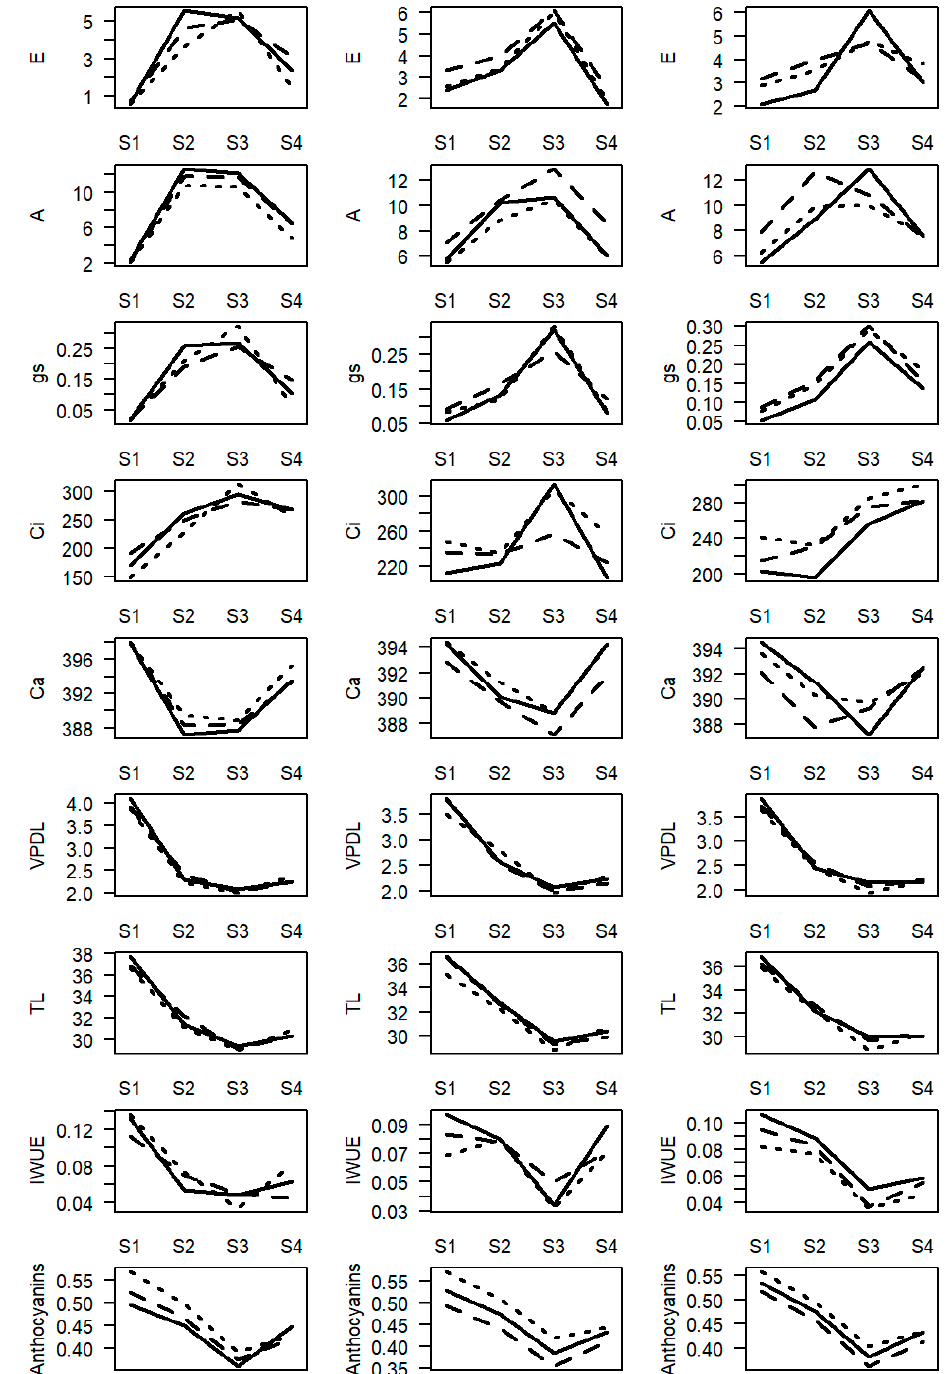
Figure 3. Averages of the physiological variables of coffee with the greatest discriminating power between systems (dryland farming in the left column, irrigation in the center, fertigation in the right), genotypes (clone “25”, continuous line; clone “08”, dashed line; clone “03”, dotted line), and seasons (S1—peak of the dry season; S2—beginning of the rainy season; S3—peak of the rainy season; S4—beginning of the dry season). E—transpiration rate (mmol H 2 O m − 2 s − 1 ), A—net